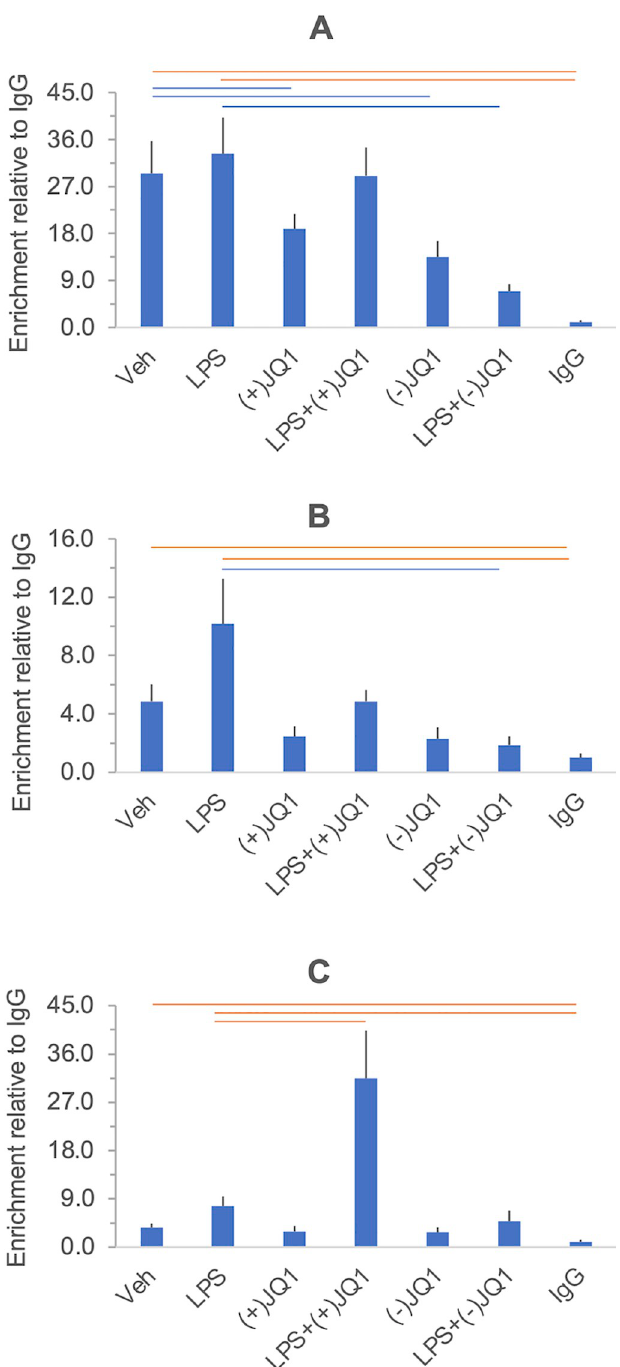
Fig 7. The effects of LPS, (+)-JQ1 and (-)-JQ1 on histone 3 acetylation at the IL6 (Panel A) CXCL8/IL8 (Panel B) and TNF (Panel C) promoters in DSCs. Primary cultures of DSCs were treated with vehicle, LPS, (+)-JQ1, (-)-JQ1, and their combinations indicated under the columns. Histone 3 acetylation was determined by chromatin immunoprecipitation (ChIP) using a pan-acetyl histone 3 antibody (listed in S2 Table), and the results were expressed relative to the negative control IgG. Further details of the experimental procedures and the data processing are described in the Materials and methods section. Columns show the mean ± SEM, n = 5–6 independent experiments. Significant differences (at 5% FDR), highlighted in the heatmap in Fig 6, are indicated by the horizontal orange and blue lines. The results of the individual experiments and summary statistics are presented in the S1